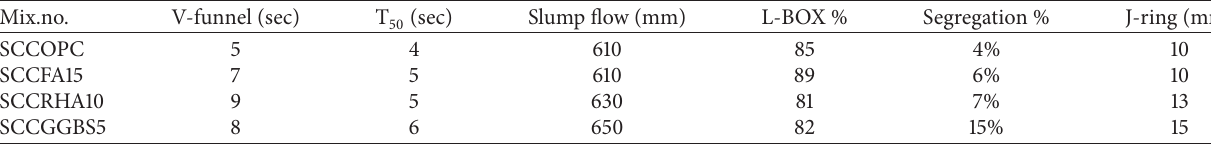
Table 4: Results of workability fresh SCC containing SCM.